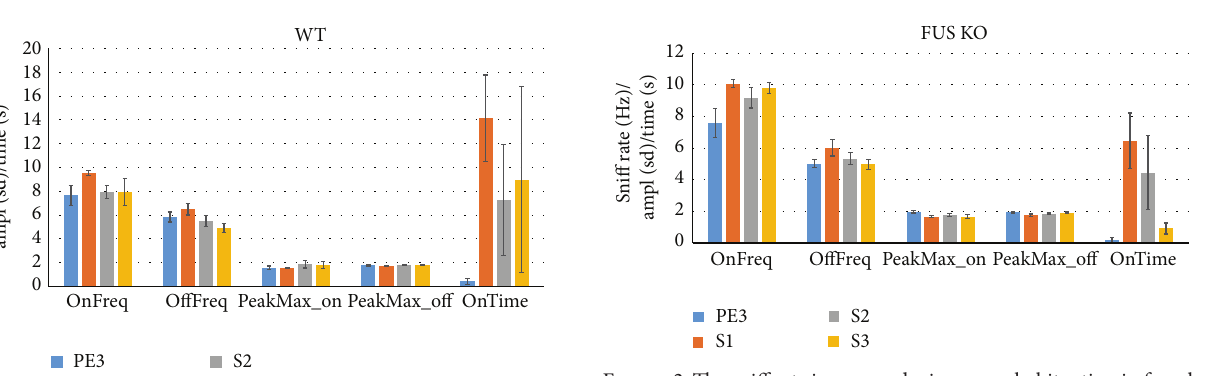
Figure 2: The sniff rate increases during cross-habituation in female FUS ko mice. The same as Figure 1, but now for FUS knock- out (ko) mice ( 𝑛 = 13 ), which have chronic oxidative stress and are a new model of accelerated aging. OnFreq and OffFreq: sniff rate (Hz); PeakMax on and PeakMax off: sniff peak amplitude (standard deviations of 𝑧 -scored pressure signal). OnTime: odor object exploration time (s). All data are mean ±